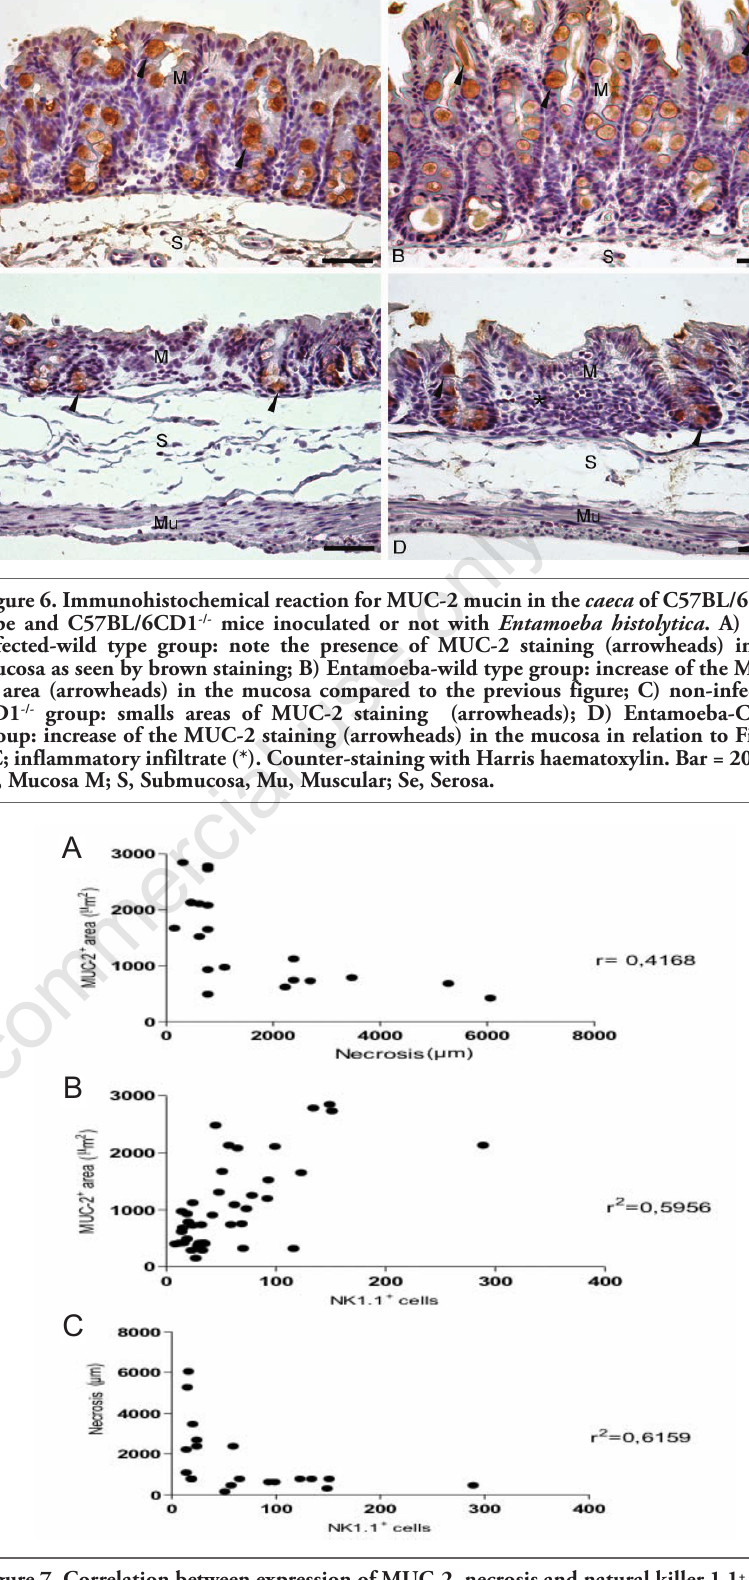
Figure 7. Correlation between expression of MUC-2, necrosis and natural killer 1.1 + lym- phocytes. A) Correlation between MUC-2 + areas and extension of necrosis. Data shown as determination coefficient r. P<0.05; B) Correlation between MUC-2 + area and number of NK1.1 + lymphocytes. Data shown as determination coefficient r 2 . P<0.05; C) Correlation between extension of necrosis and number of NK1.1 + lymphocytes. Data shown as deter- mination coefficient r2.